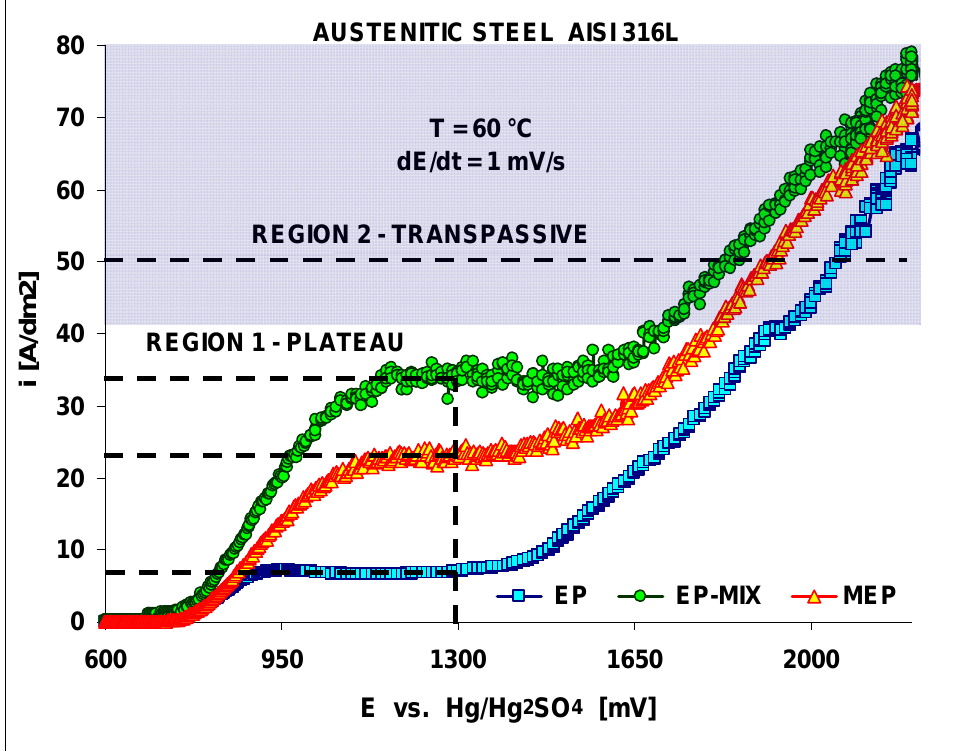
Figure 3. Electropolishing polarization characteristics obtained on AISI 316L SS dependent on treatment conditions (EP, EP with moderate mixing, and MEP) presenting two regions: 1 – plateau, 2 – transpassive. The semi-shadowed current density area of typical industrial applications has been